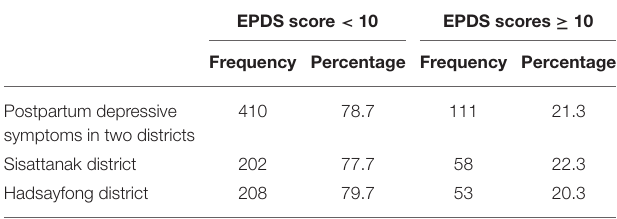
TABLE 3 | Prevalence of postpartum depressive